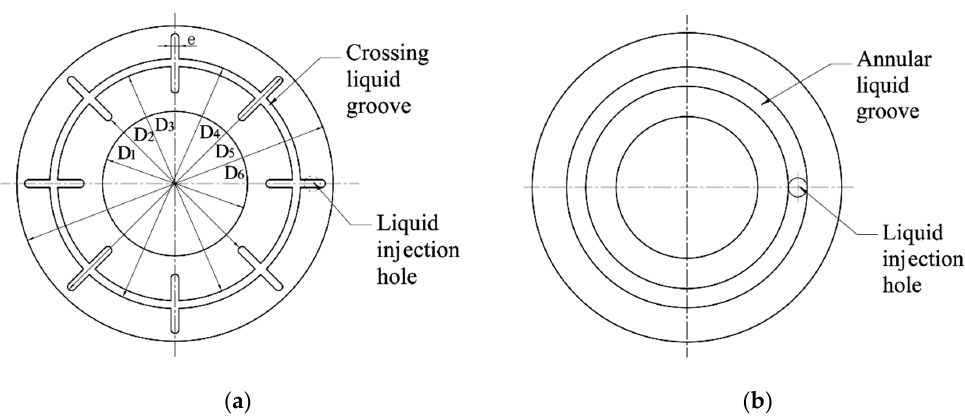
Figure 2. Structure of HTB: ( a ) HTB with crossing groove; ( b ) HTB with annular groove.